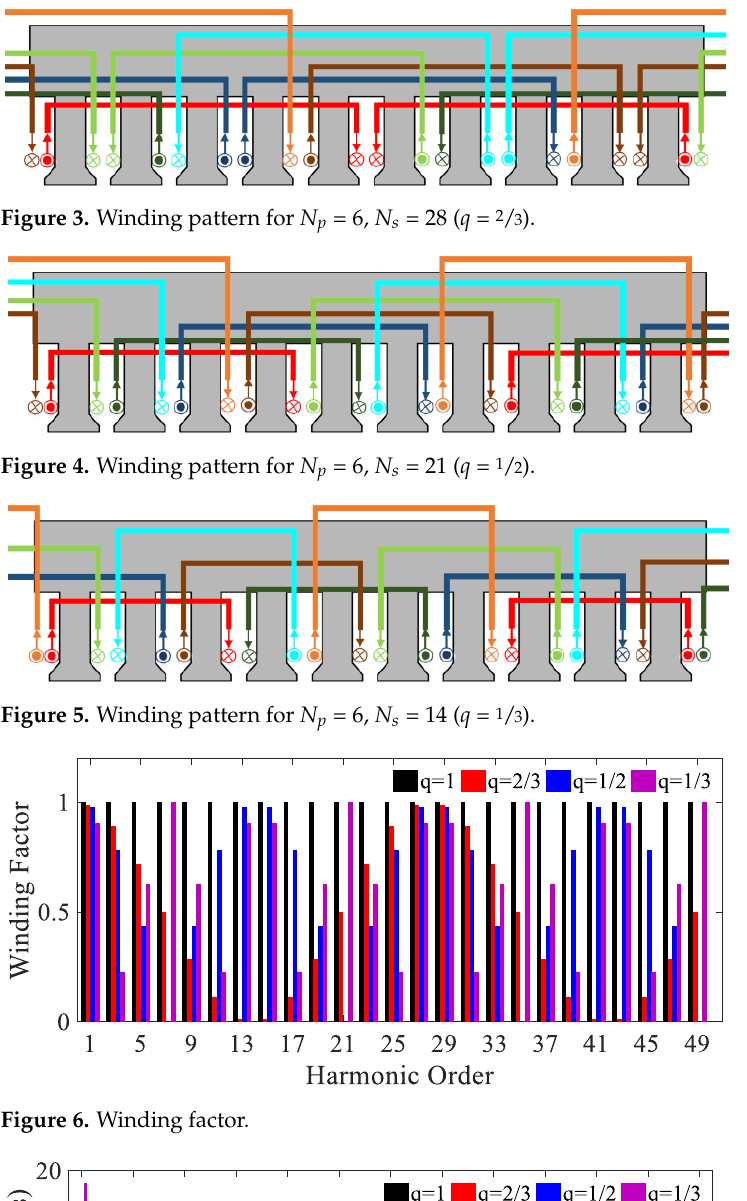
Figure 2. Winding pattern for N P = 6, N S = 42 (q = 1).